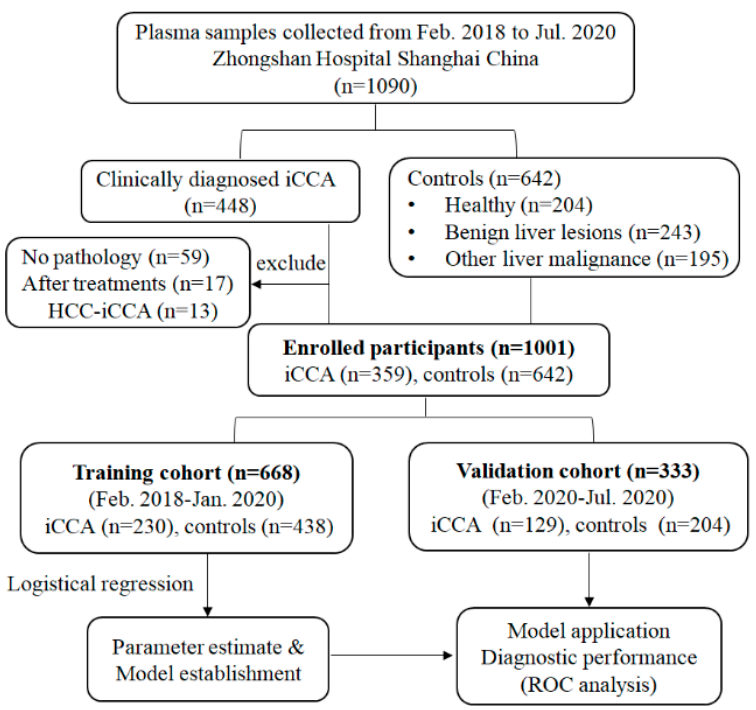
Figure 1. Flow chart of study design. iCCA, intrahepatic cholangiocarcinoma; HCC-iCCA, combined hepatocellular carcinoma and intrahepatic cholangiocarcinoma; ROC, receiver operating characteristics.